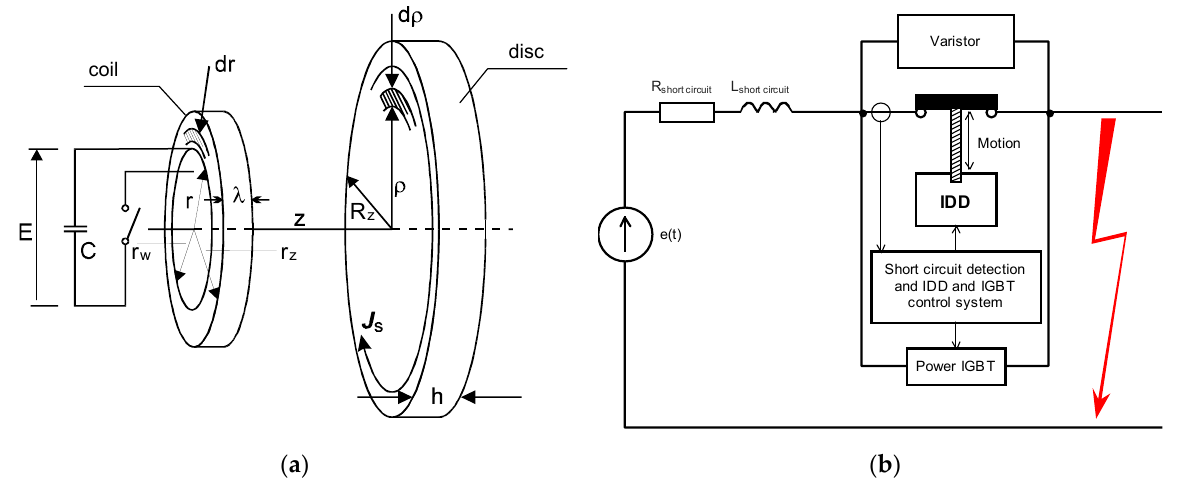
Figure 1. ( a ) Inductive–dynamic drive (IDD); ( b ) block diagram of hybrid circuit breaker. Where rw, rz, λ , Rz, h—coil and disc dimensions; Js—eddy current density; C, E—capacitance and initial volt ‐ age.